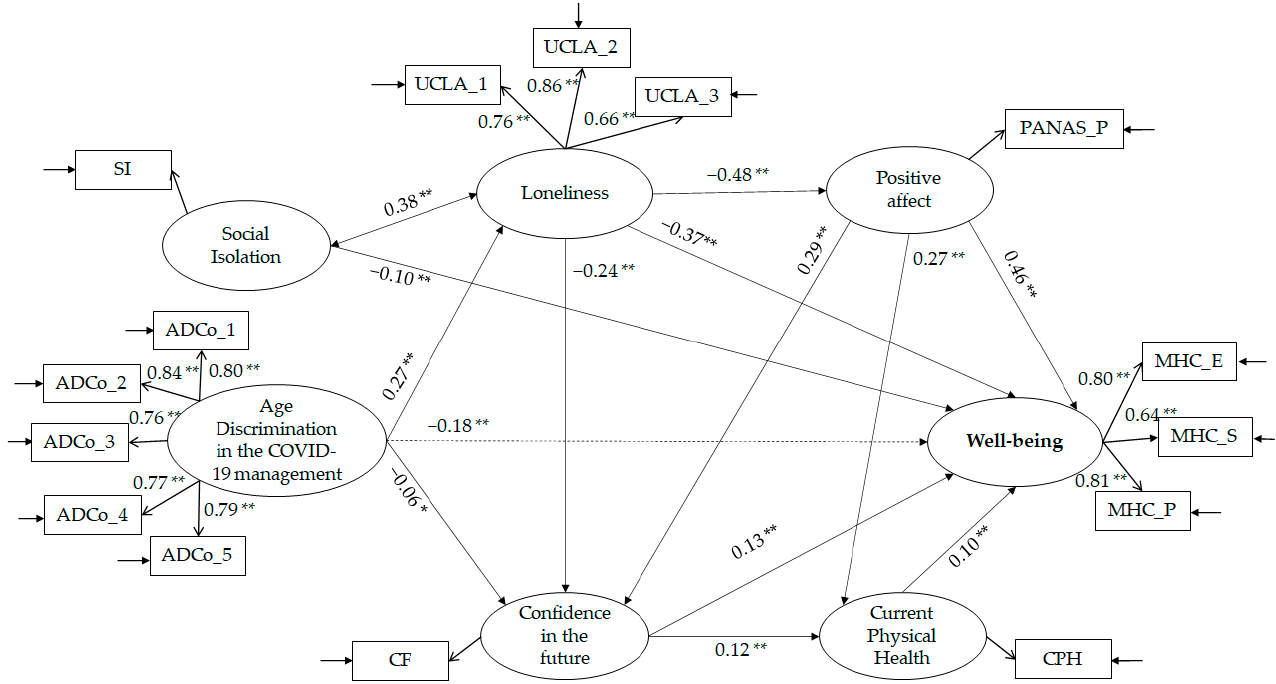
Figure 2. Structural equation models with standardised coefficient estimates (** p < 0.001; * p = 0.05).